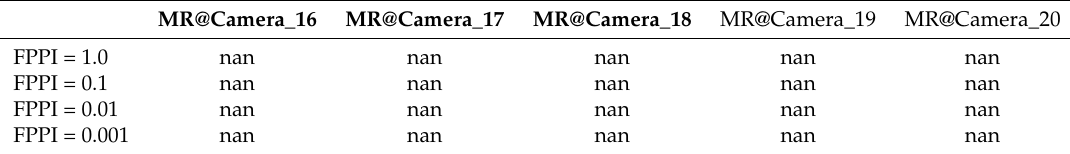
Table 10. Accuracy table @ Cameras_16–20, YOLOv3.